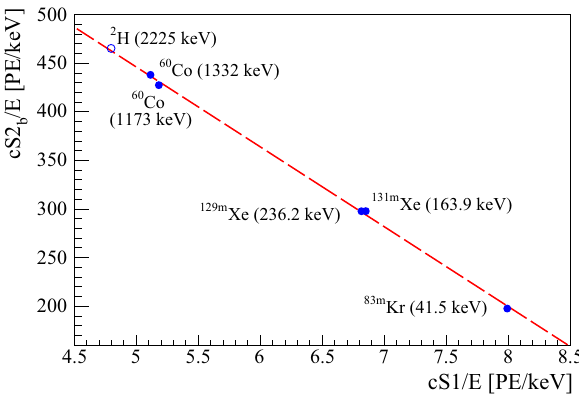
Fig. 24 The position-corrected S1 and bottom S2 signals of the 83 m Kr isomer decay allows for the determination of the light and carge yields at 41.5keV. The 83 m Kr decay produces two consecutive conversion electrons which are combined for this analysis 0 . 007 ) PE/ γ and g 2 b = ( 11 . 5 ± 0 . 8 ) PE/e − from a fit.